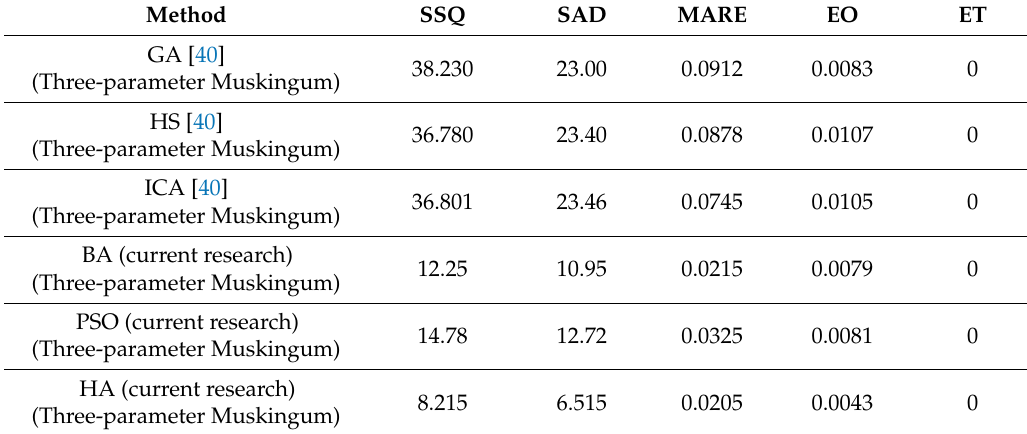
Table 6. Comparison of results for Wilson flood.